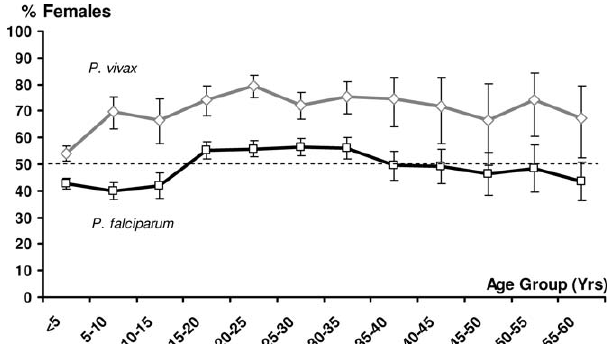
Figure 2. Age-Stratified Percentage of Females in Patients Hospitalised with P. falciparum (Squares) and P. vivax Infection (Diamonds) Error bars represent 95% CI, and dotted line denotes males and females present in equal proportions.